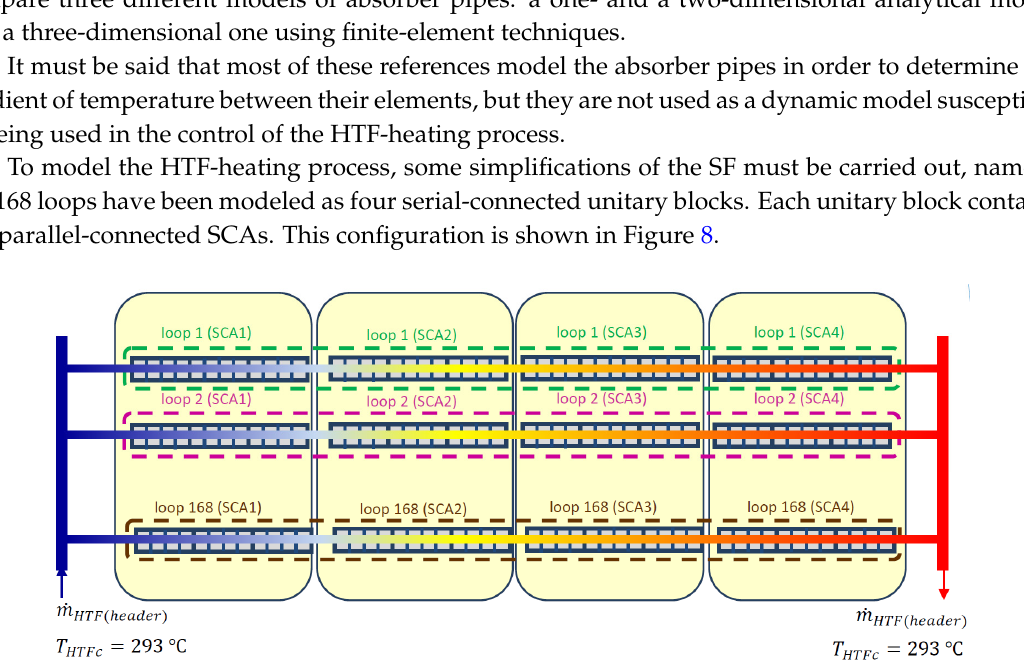
Figure 8. Loop simplification.